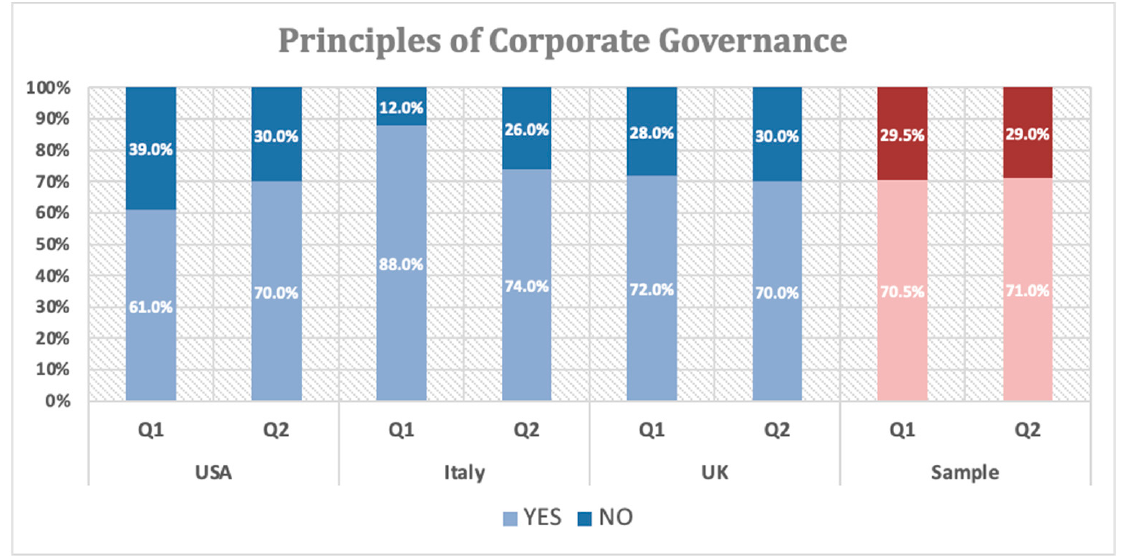
Figure 2. Answers to questions about the principles of corporate governance (1 and 2) by country of respondents.